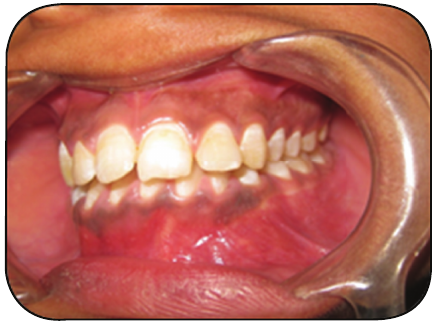
Figure 2: Preoperative intraoral photograph.